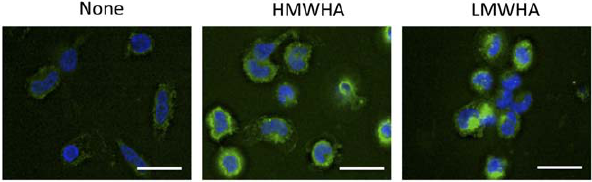
Figure 9. At 30 minutes, both LMWHA and HMWHA are internalized by monocytes. Purified human monocytes were incubated in SFM, SFM with 300 m g/ml LMWHA, or 300 m g/ml of HMWHA for 30 minutes. The PBMC were stained with biotinylated hyaluronic acid binding protein (HABP) and this was detected with streptavidin-FITC. In all panels, nuclei are stained blue with DAPI and bars are 20 m m. The figures represent one of the 3 independent